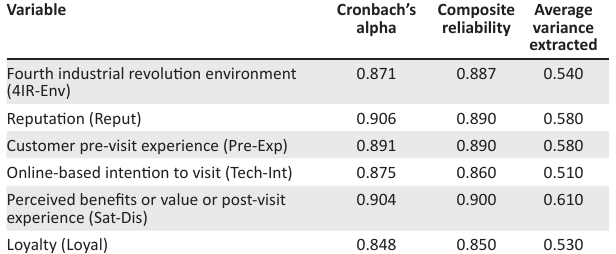
TABLE 2: Respondents’